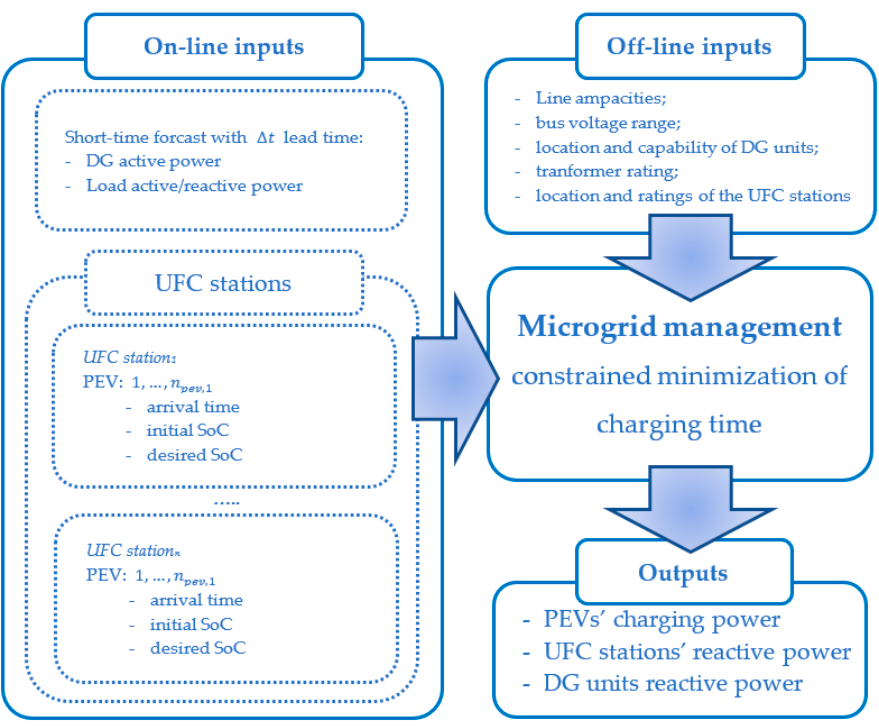
Figure 2. Flow chart scheme of the proposed real-time scheduling strategy.